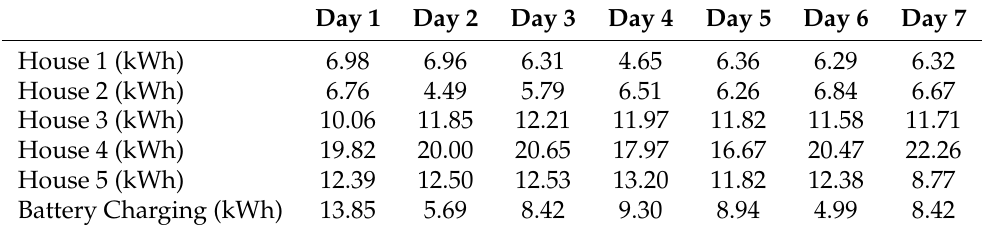
Table 3. Houses and battery consumption for every day of the week after applying the model.